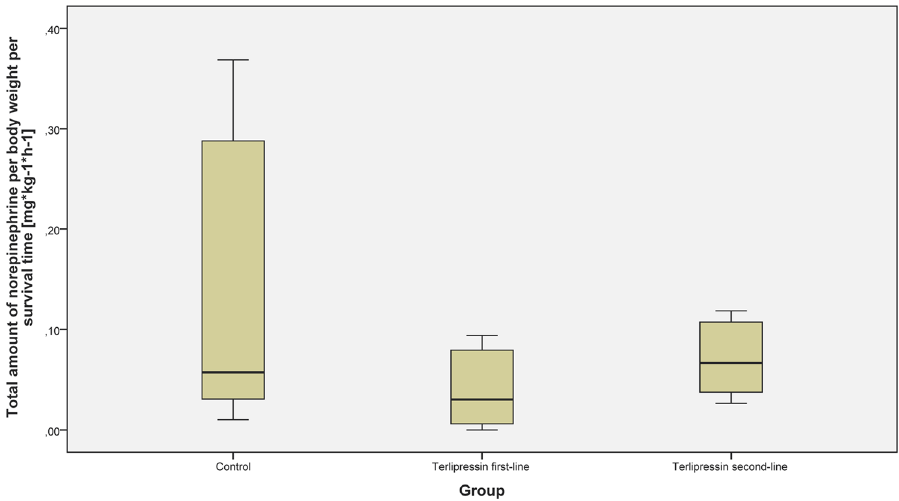
Figure 2. Cumulative norepinephrine amount of the study animals. The figure demonstrates the cumulative norepinephrine dose of the study animals averaged over the 24-hour interventional period. Data are presented as median [interquartile